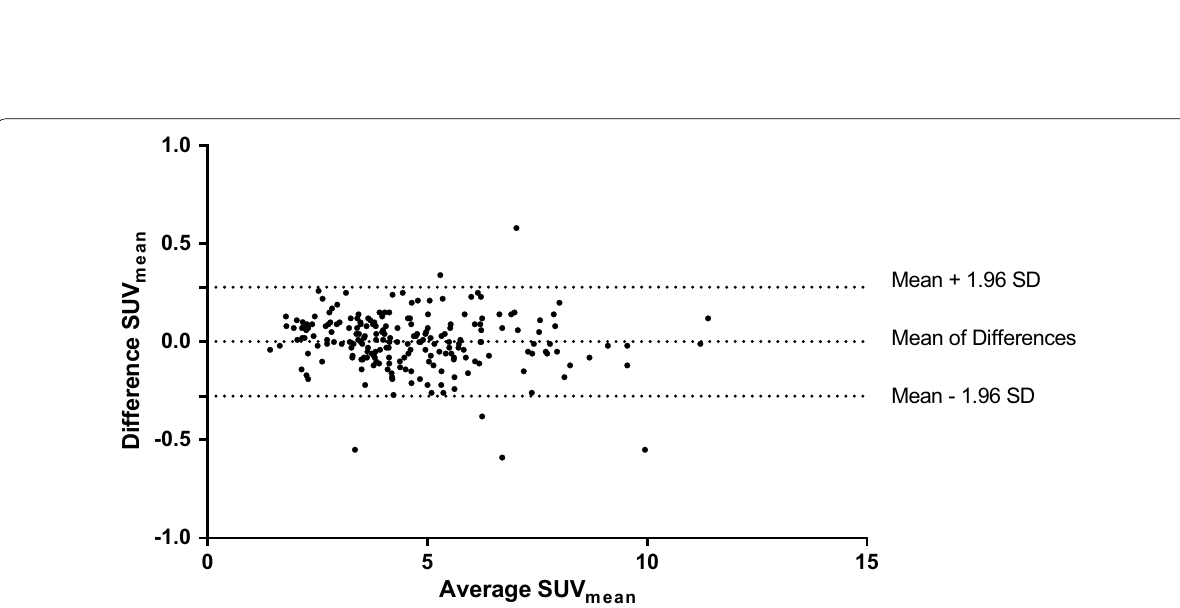
Fig. 6 Bland–Altman plot showing SUV mean measurement differences of 214 lesions between 75 s and 57 s PET/CT datasets plotted against the mean SUV mean . In order to interpret these powerful Bland–Altman plots properly, it is essential to know that the differences between the quantified SUVs are plotted on the y- axis, and the average of the SUVs is visualized on the x-